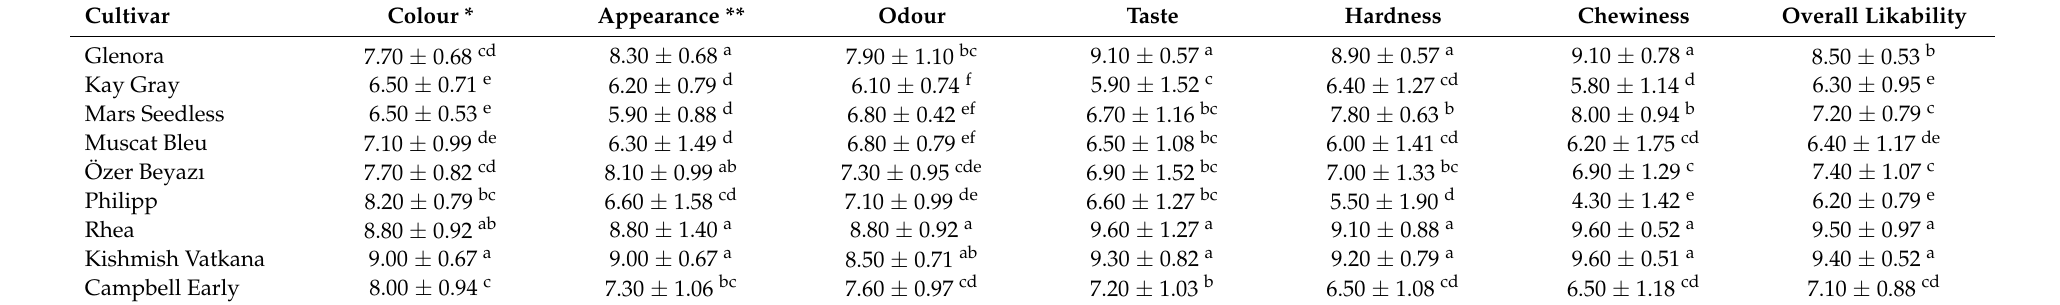
Table A5. Results of sensory evaluation of the raisins of different grape cultivars on a scale from 1 (dislike very much) to 10 (like very much).